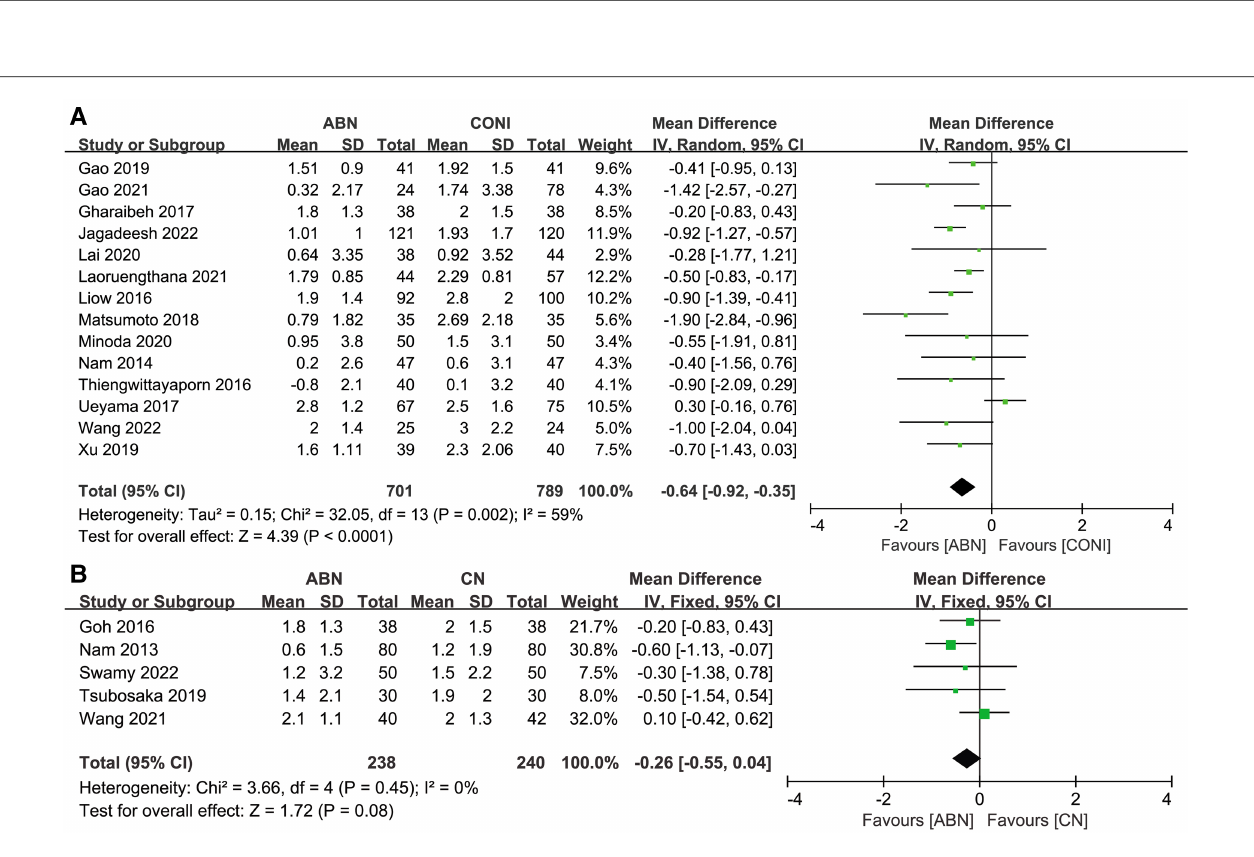
FIGURE 2 ( A ) Risk of bias for the included studies (+: low risk, ?: unclear risk, − : high risk); ( B ) overall risk of bias for all studies; ( C ) the funnel plots of the coronal femoral angle.